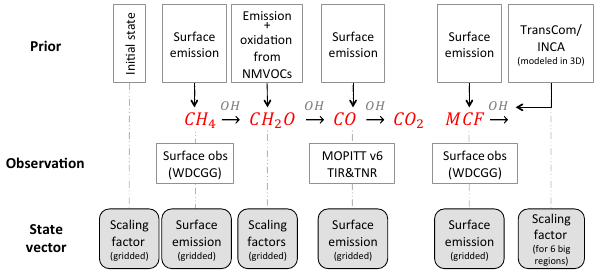
Figure 1. Schematics of the input information provided to the in- version and of the inversion state